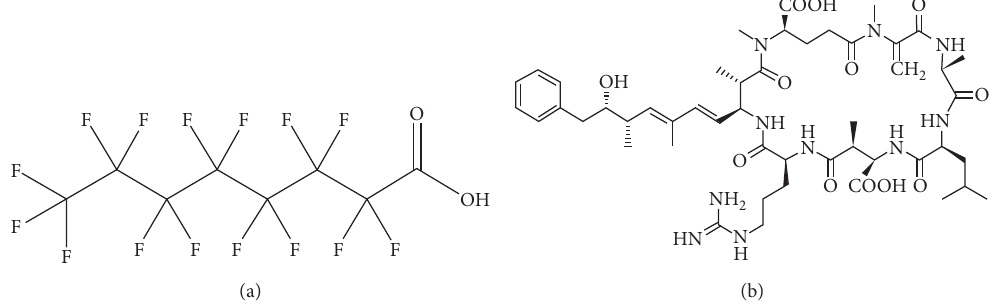
Figure 1: Molecular structures of (a) perfluorooctanoic acid (PFOA) and (b) microcystin (Kondo et al.